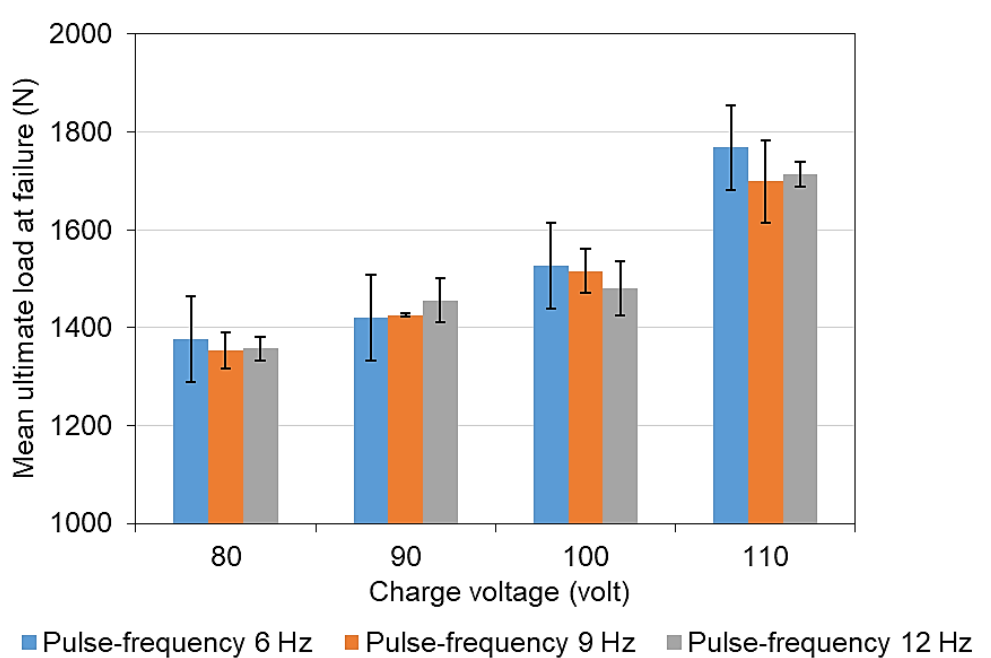
Figure 15. E ff ect of laser parameters on ultimate load at failure ± SD (length of welding 10 Figure 15. Effect of laser parameters on ultimate load at failure ±SD (length of welding 10 mm).